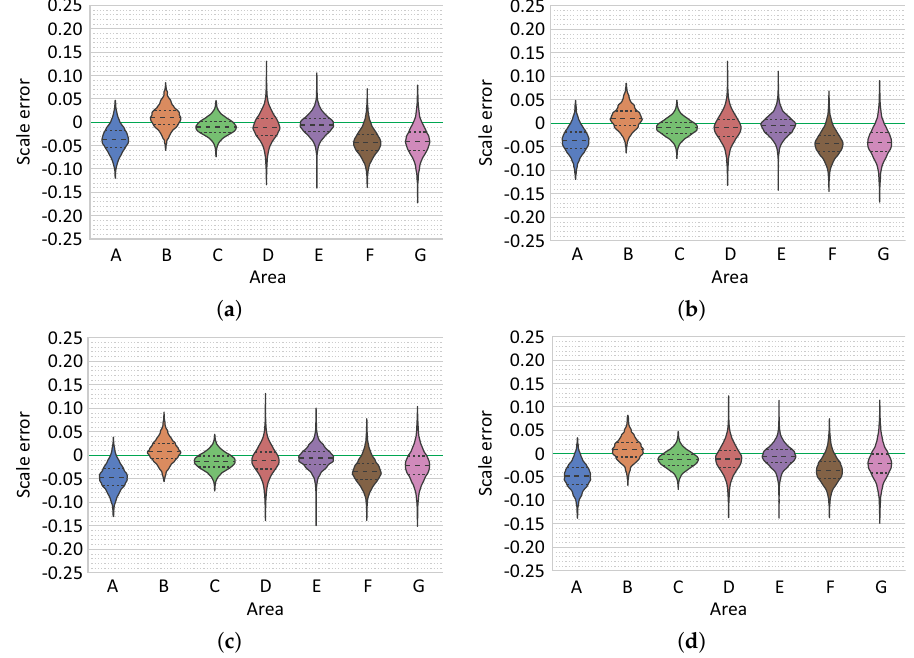
Figure 23. Estimated scale errors per segment for model FPA: ( a / b ) Global/Incremental SfM with similarity transformation navigation fusion. ( c / d ) Global/Incremental SfM with multiobjective BA navigation fusion. Table 4. Estimated scale errors (%) per segment for different reconstructions of FPA area (values represent mean value with standard deviation). A B C G Global SfM w/Similarity T.